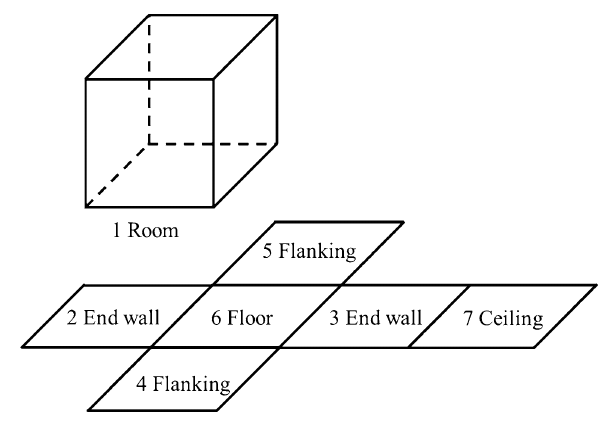
Fig. 3 Exploded view of a system consisting of two rooms sepa- rated by a common